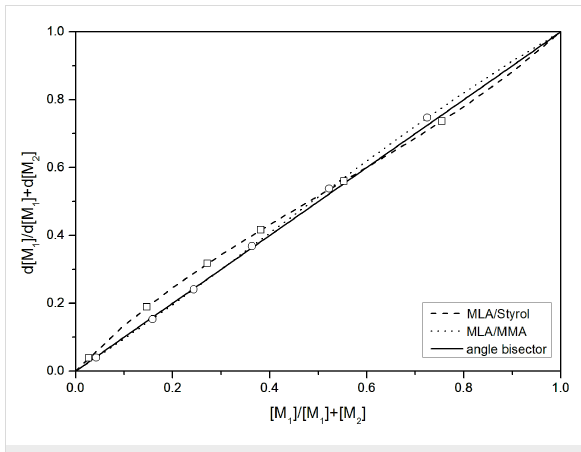
Figure 7: Copolymer composition curves for the systems MLA with styrene and